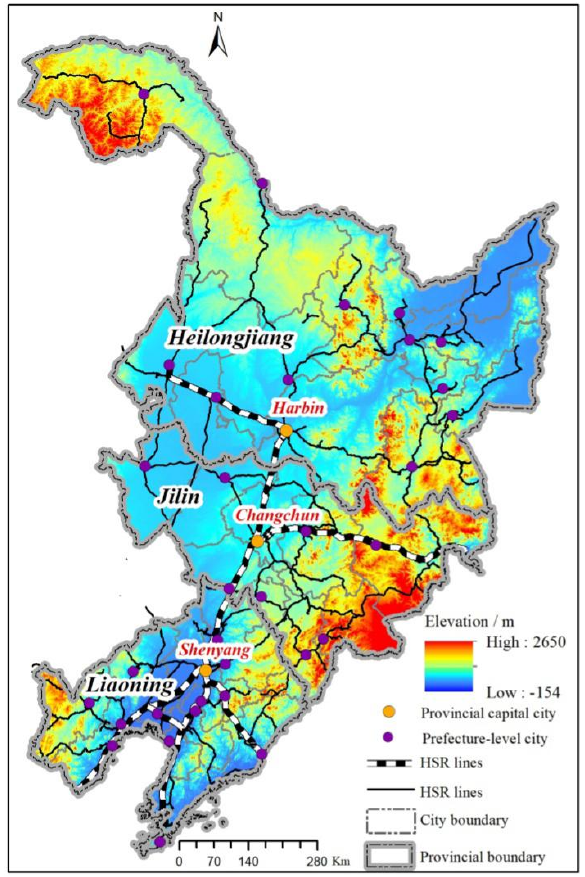
Figure 1. The study area in northeastern China comprising three provinces, namely Heilongjiang, Jilin, and Liaoning.